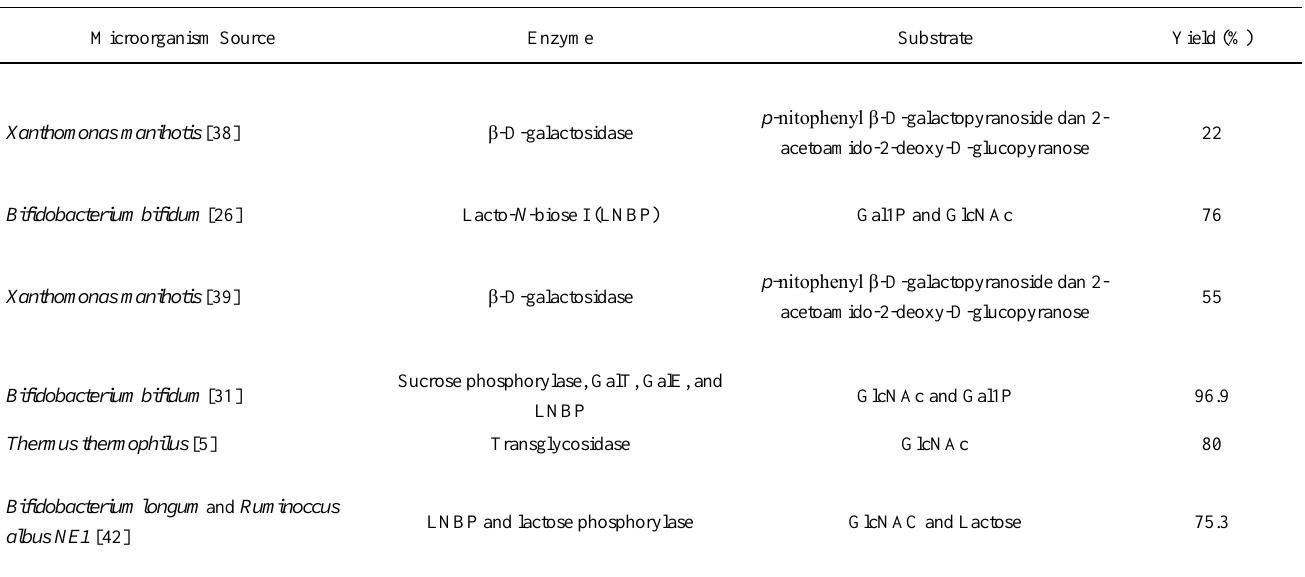
Fig. 2. Comparison of biosynthesis pathway (a) and enzymatic synthesis of lacto- N -biose I (b). LNB is connected to the the galactosyl moiety of terminal lactose through a β-1,3-binding with an extra β-1,6-binding in branched Table 2. Enzymatic synthesis of LNB in several experiments